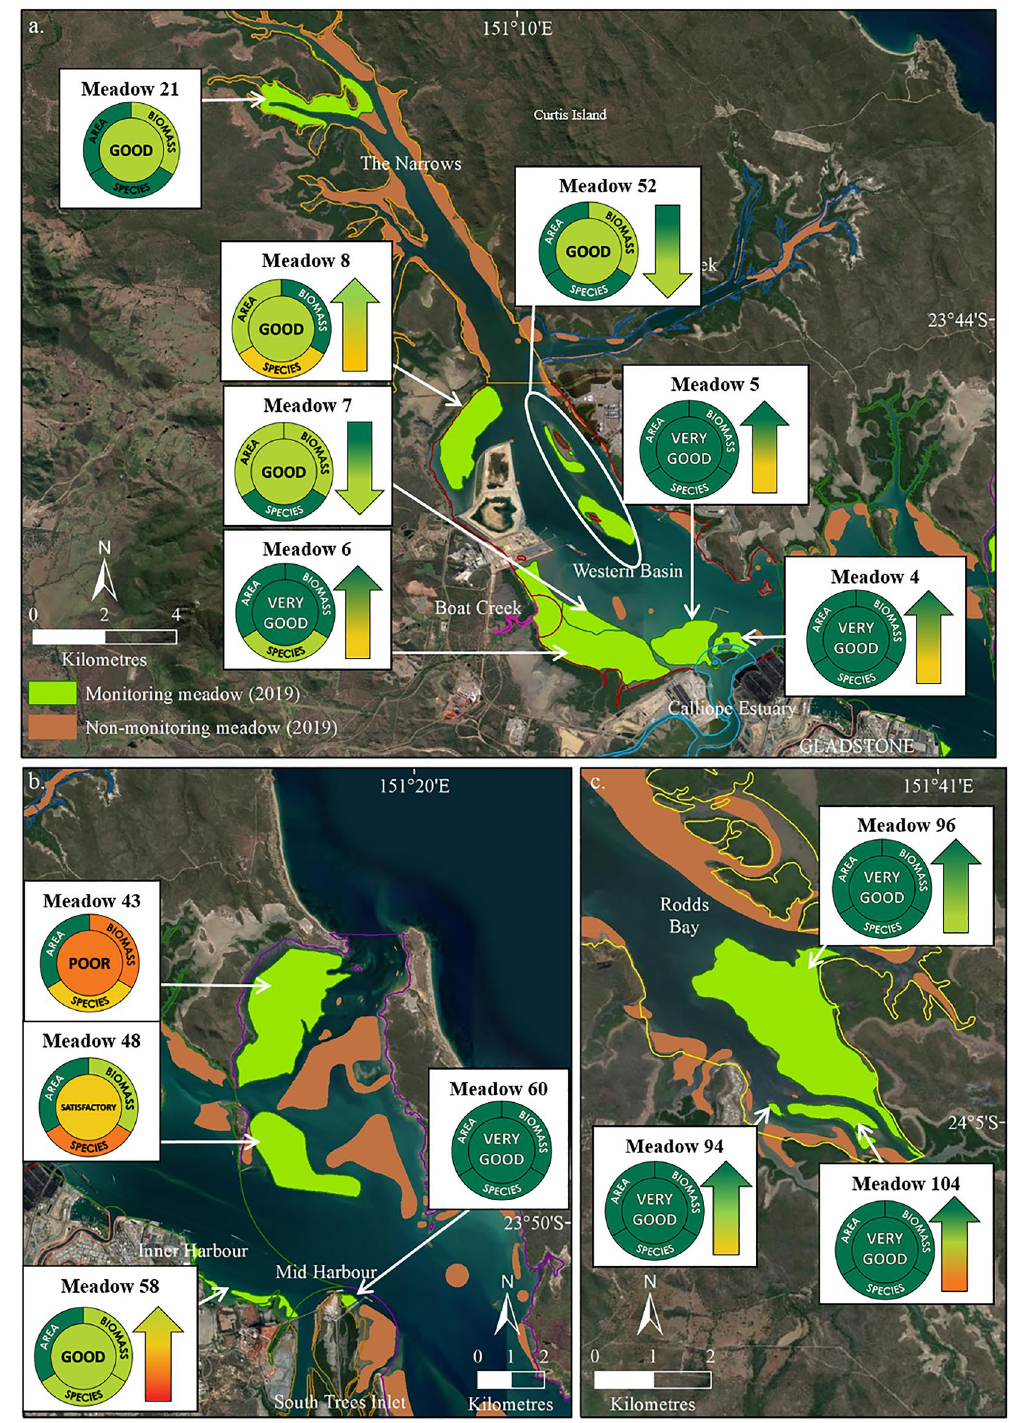
Figure 4. Seagrass condition for each indicator and overall meadow condition for 14 monitoring meadows within Gladstone Harbour Zones in 2020 report card (November 2019 field survey). ( a ) The Narrows, Graham Creek and Western Basin, ( b ) Inner Harbour, Mid Harbour and South Trees Inlet, and ( c ) Rodds Bay. Changes in overall meadow condition relative to the previous year’s report card are described using arrows; an “up” arrow indicates an improved grade change; a “down” arrow indicates a decline in grade; no arrow indicates the grade is unchanged (stable). Map created using ArcGIS software version 10.8 by Esri (www. esri. com). Satellite image copyright